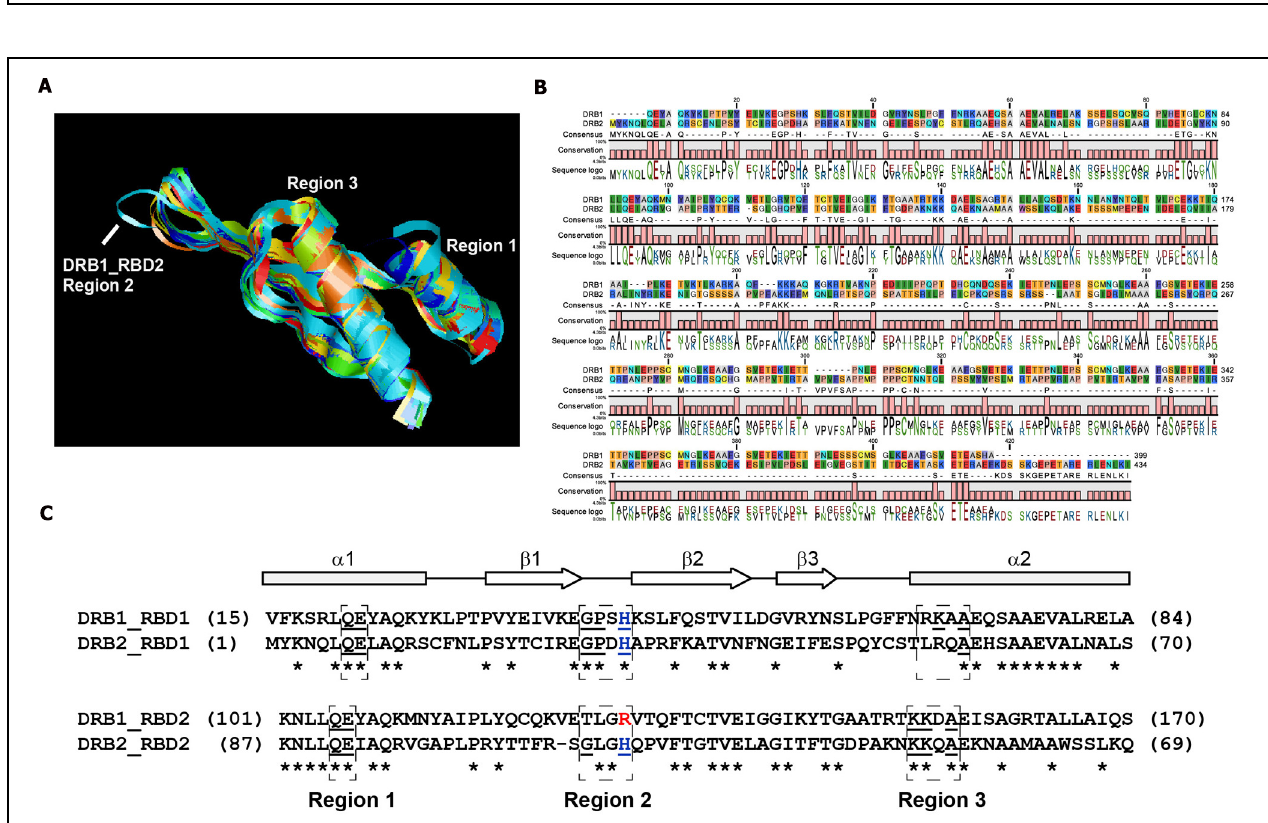
FIGURE 5 | Comparison of the conservation between identified DRB1 and DRB2 orthologs. The full-length sequences of DRB1 and DRB2 orthologs were scaled to the same size for direct comparison and the level of amino acid sequence conservation across these two DRB proteins schematically shown.